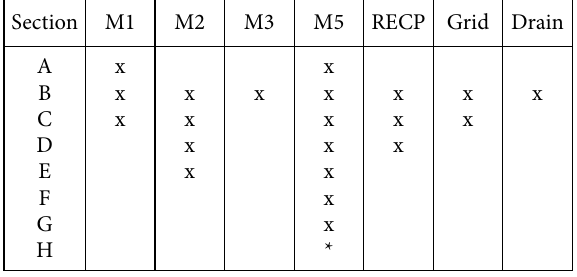
Table 2. Overview of materials installed in the test dike Section